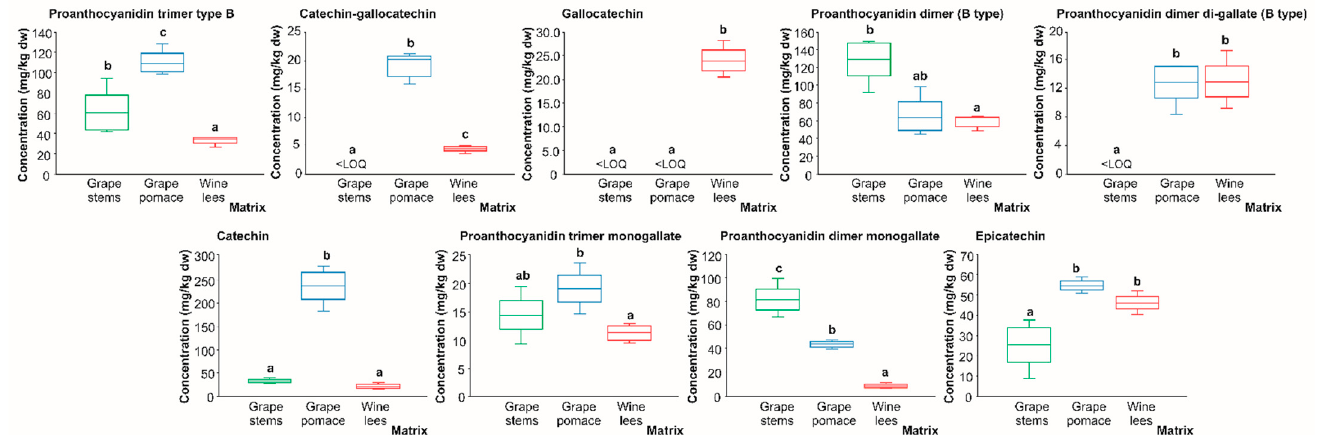
Figure 6. Box plots with quartiles (upper values 75%, median 50%, and lower values 25%) of individual catechin derivatives and proanthocyanidins (mg/kg dw) of (poly)phenolic extracts of grape stems (green box), grape pomace (blue box), and wine lees (red box). Boxes with a different letter (a,b,c) within each plot indicate statistically significant differences ( p < 0.05) according to the one-way analysis of variance (ANOVA) and Tukey’s multiple range test. <LOQ, lower than the limit of quantification.